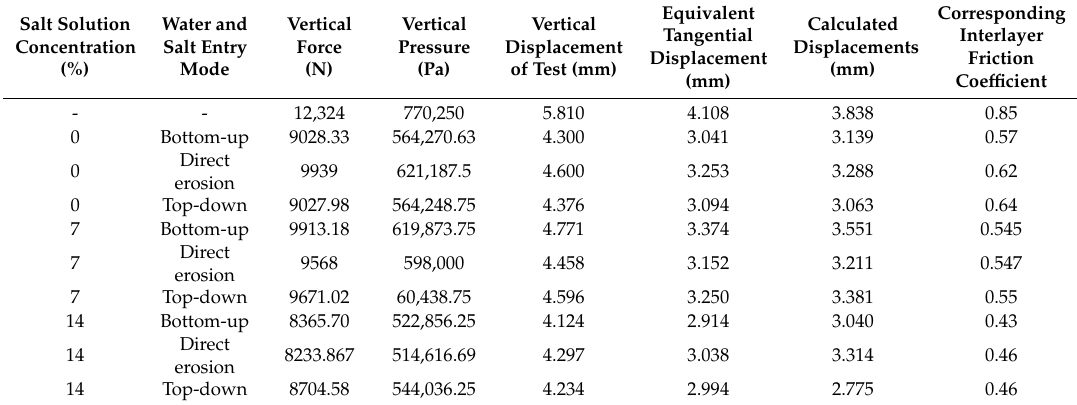
Table 2. Comparisons between experimental results and numerical simulation results.